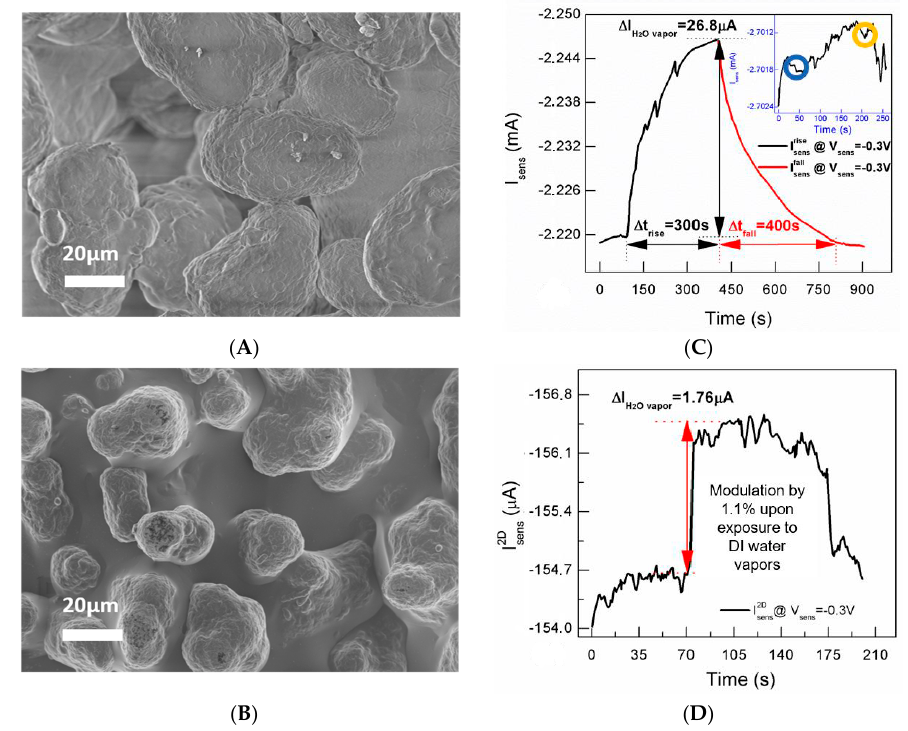
Figure 2. SEM images of ( A ) the sintered polyamide (1500 × ) and ( B ) the same coated by a poly(3,4-ethylenedioxythiophene):polystyrene sulfonate (PEDOT:PSS) film (1000 × ); ( C ) real-time I sens change produced by water vaporization at a distance of 1 mm (black branch) and reversibility check (restoring of the initial I sens value upon removal of the water reservoir, red branch). The inset shows the device behavior upon exposure to an empty reservoir and removal of the same reservoir (20 s lasting e ff ects on the recorded current upon reservoir exposure and removal are indicated by the blue-circled and orange-circled regions,